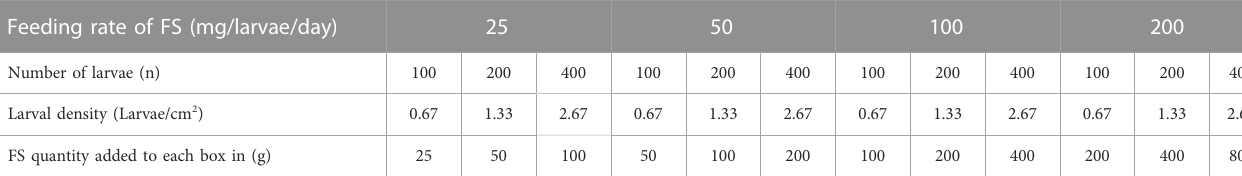
FS quantity added to each box in (g)